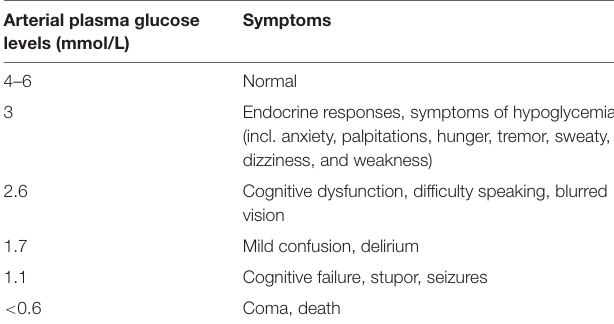
TABLE 1 | Symptoms arising from depleted arterial plasma glucose levels (Mergenthaler et al.,